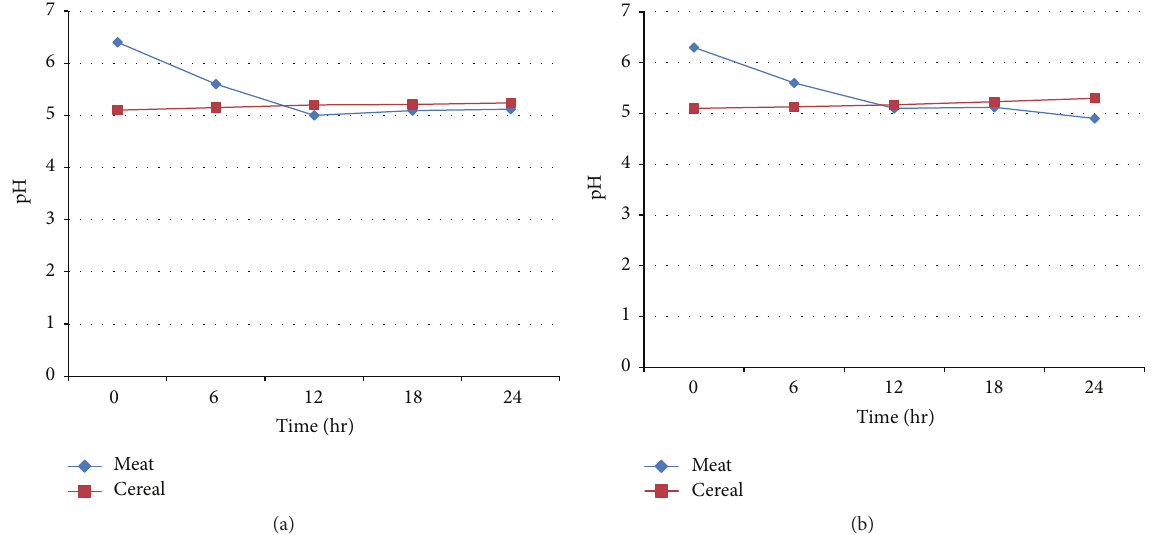
Figure 2: pH values of meat and cereal products challenged with species of Salmonella (a) and Shigella (b) isolated from diarrheal outpatients (Jimma University Specialized Hospital,